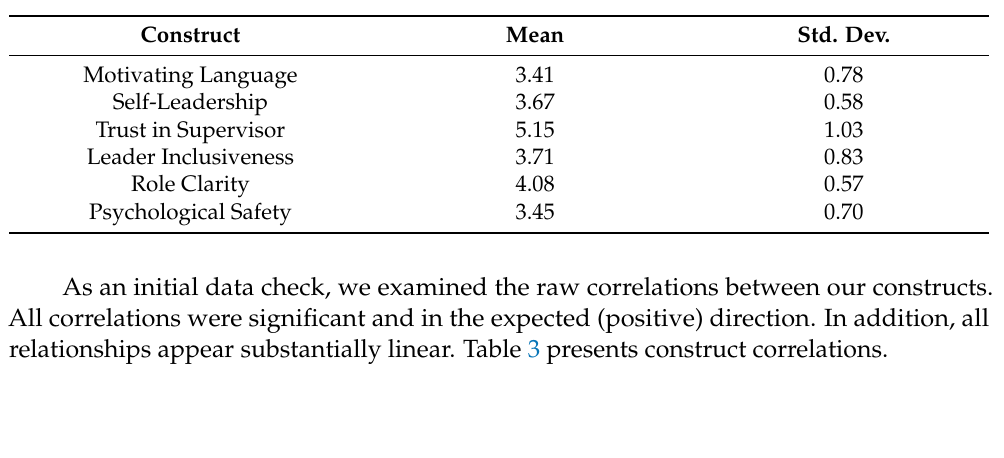
Table 2. Study Measure